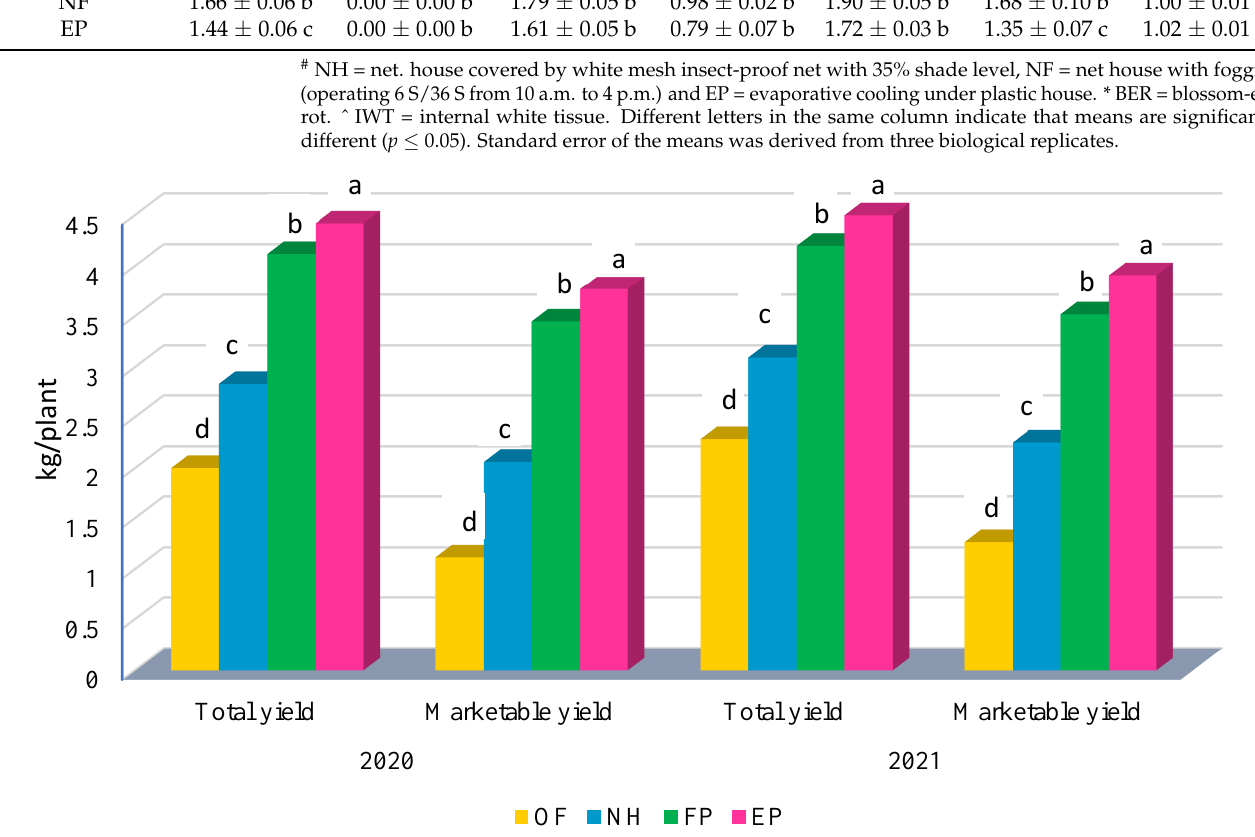
Figure 10. Total and marketable fruit yields of tomato in the open field (OF), net house (NH), net house with fogging (NF) operating 6 S/36 S from 10 a.m. to 4 p.m. and evaporative cooling under plastic house (EP). Different letters above the bars indicate that means are significantly different ( p ≤ 0.05). Presented data are the mean of 3 biological